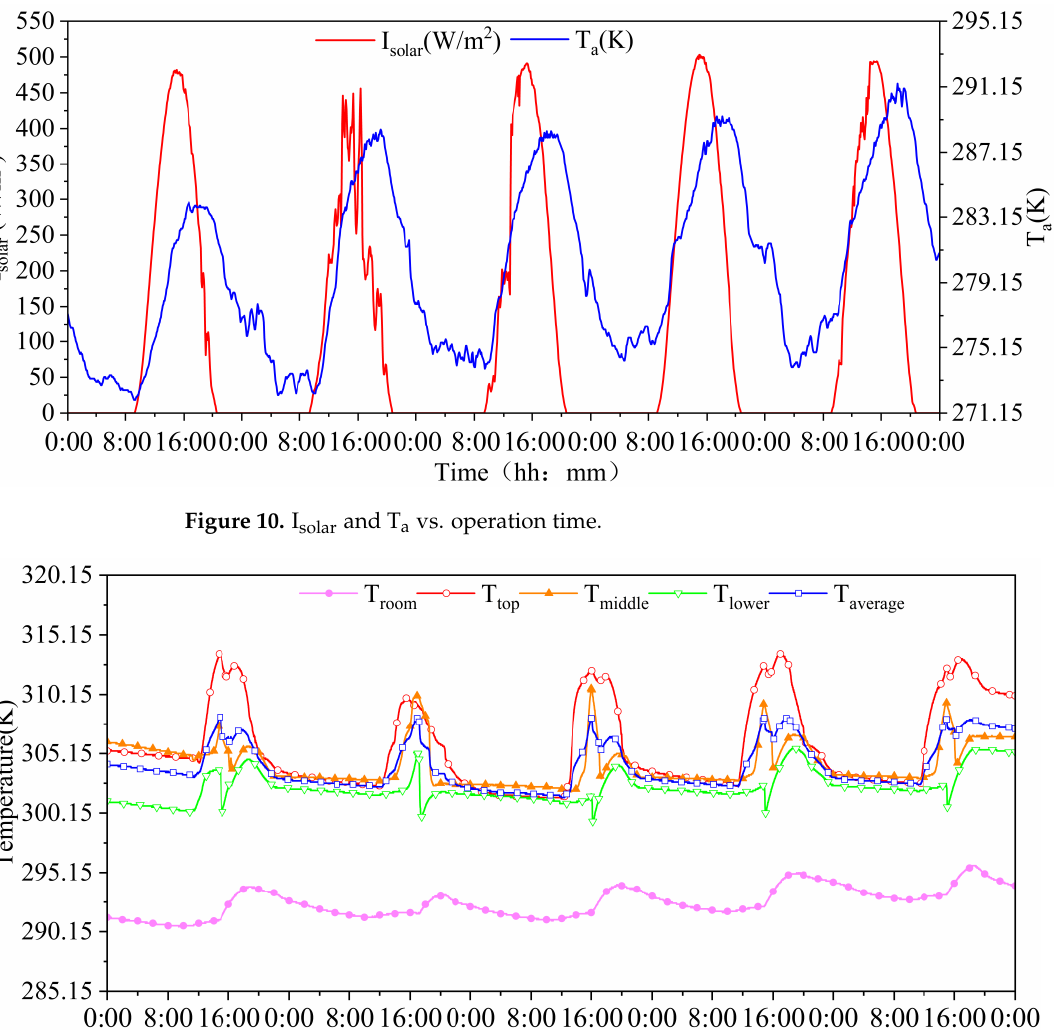
Figure 11. HST temperature and T room vs. operation time.